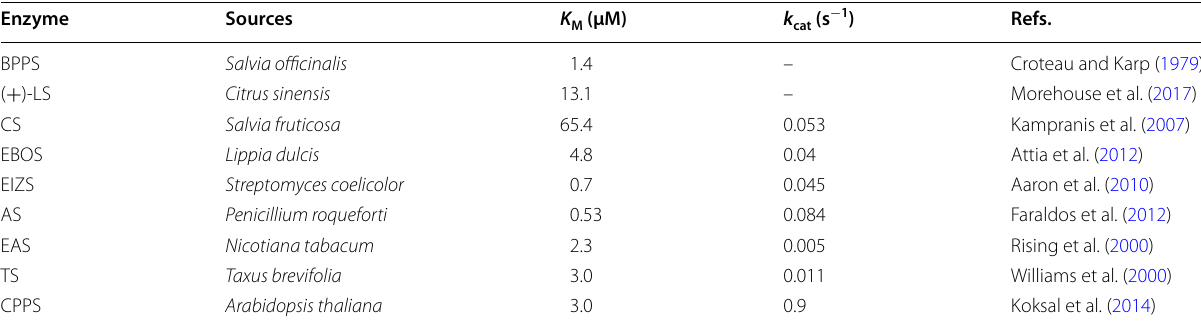
Table 1 Kinetic parameters of terpene cyclases reported